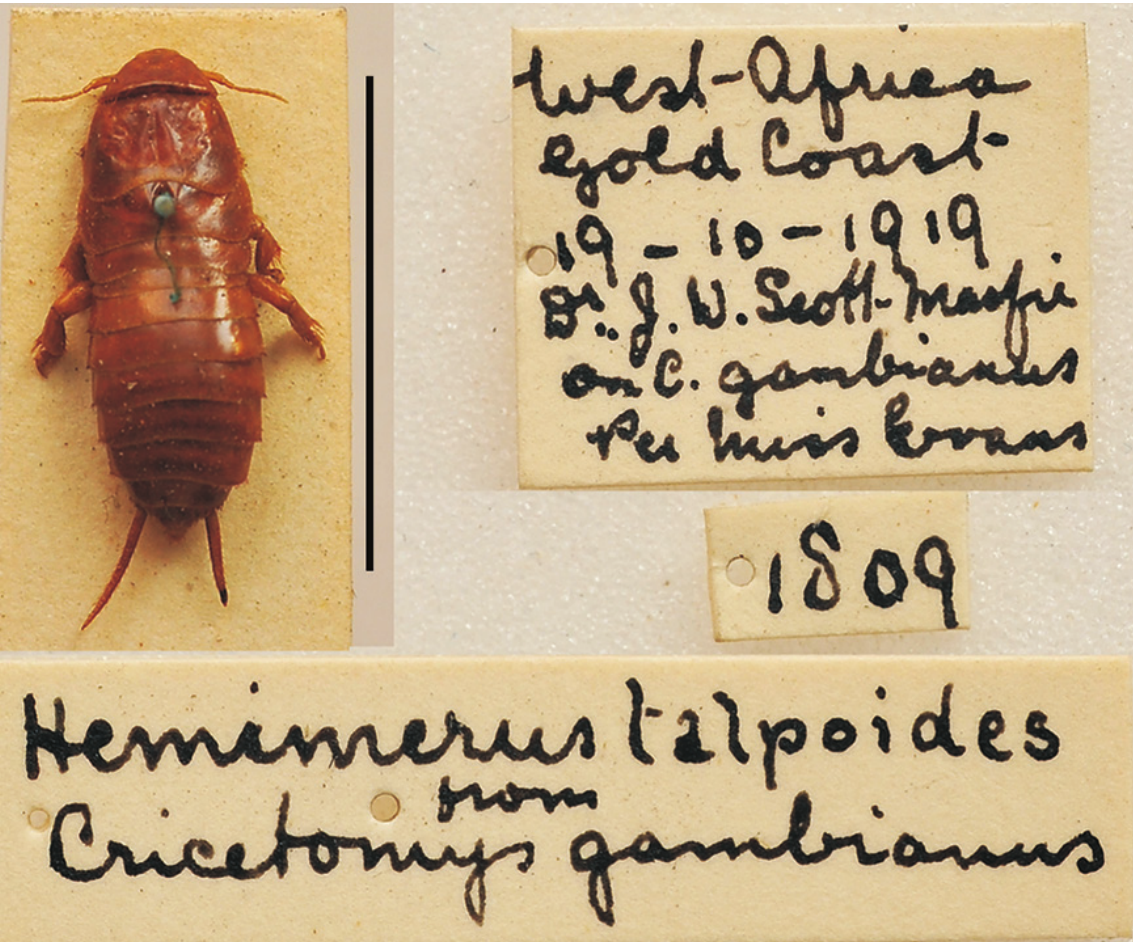
Fig. 18. The parasitic earwig Hemimerus talpoides Walker, 1871, the Manchester Museum . Scale bar = 1